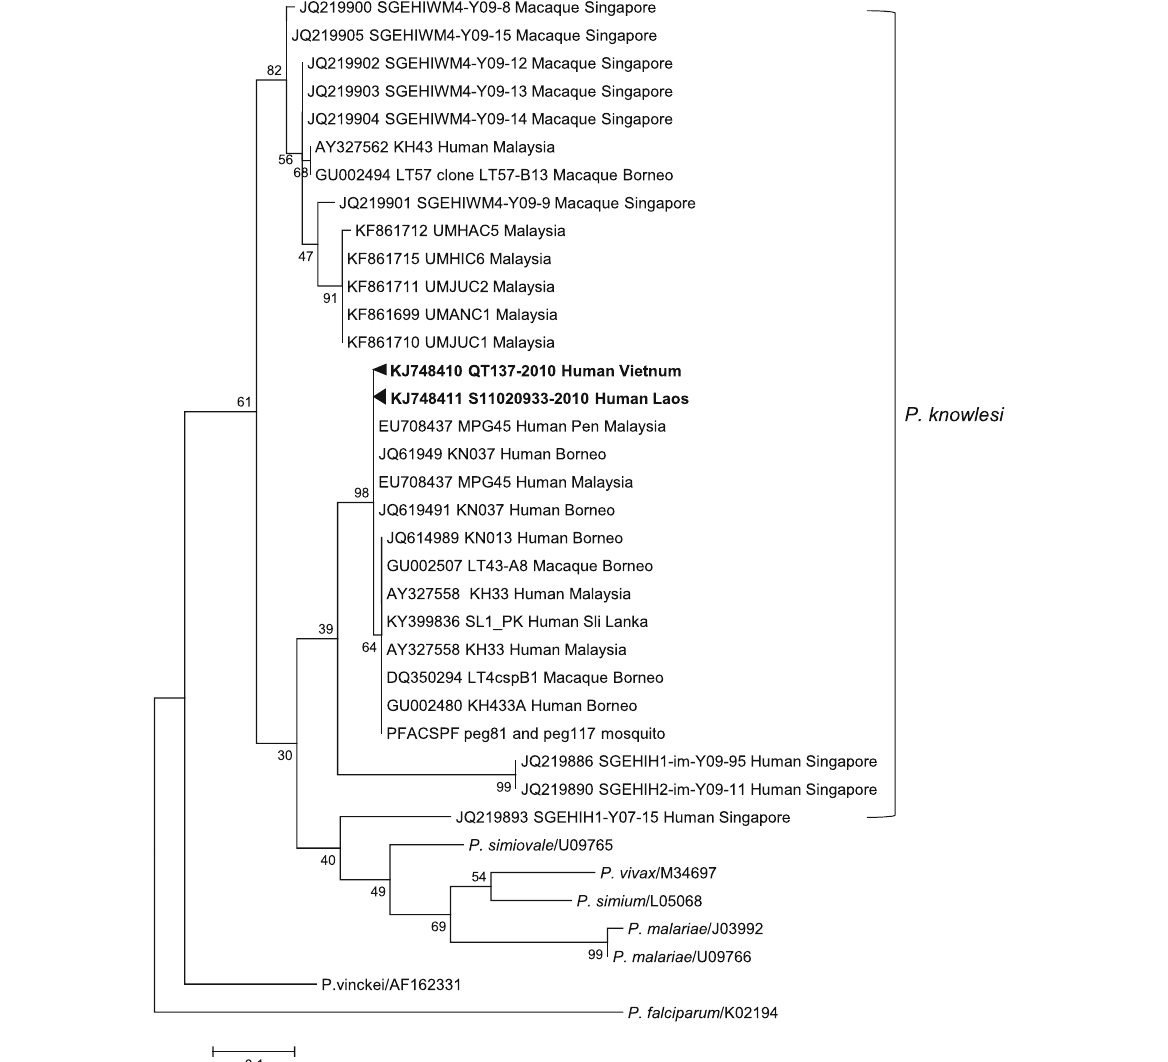
Fig. 1 Phylogenetic tree constructed from the nucleotide sequences of the CSP gene of Plasmodium spp . The evolutionary history was inferred by using the maximum likelihood method based on the Tamura-Nei model. Number of substitutions per site is indicated by the scale bar. Bootstrap values were calculated for 1000 replications. Phylogenetic analysis was conducted using MEGA7. Scale bar indicates nucleotide substitutions per